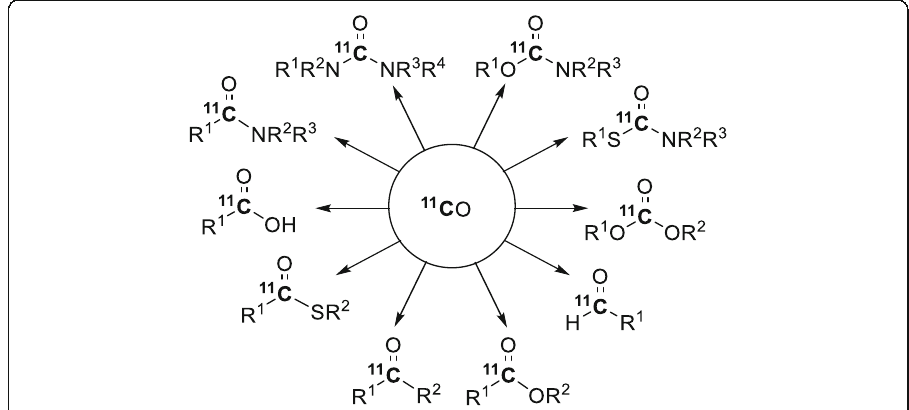
Fig. 7 Versatility of 11 C-carbonylation reactions with [ 11 C]carbon